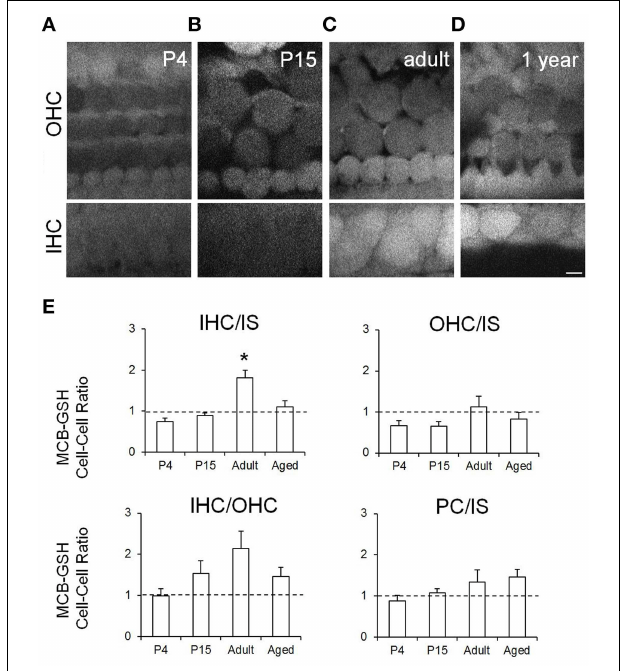
FIGURE 2 | Live imaging and quantification of MCB-GSH staining in the organ of Corti in auditory bulla explant preparations from mice at different stages of hearing development. Higher fluorescence intensities indicate greater cellular GSH content. Representative multiphoton single image planes from (A) P4 mice; (B) P15 mice; (C) adult mice (P30), and (D) ∼ 1 year old (aged) mice. Scale bar: 5 µ m. (E) MCB-GSH fluorescence quantification in OHCs, IHCs, inner sulcus cells (IS) and pillar cells (PC). Ratio values were quantified for hair cells and the IS cells (IHC/IS, OHC/IS), between the two hair cell types (IHC/OHC) and between two supporting cell types (PC/IS). Data are presented as mean ± SEM; n = 4 (P4–P6); n = 5 (P14–P16); n = 6 (P33–P41); n = 5 (P357–P424) ANOVA Tukey-Kramer’s test.; * p < 0 . 05